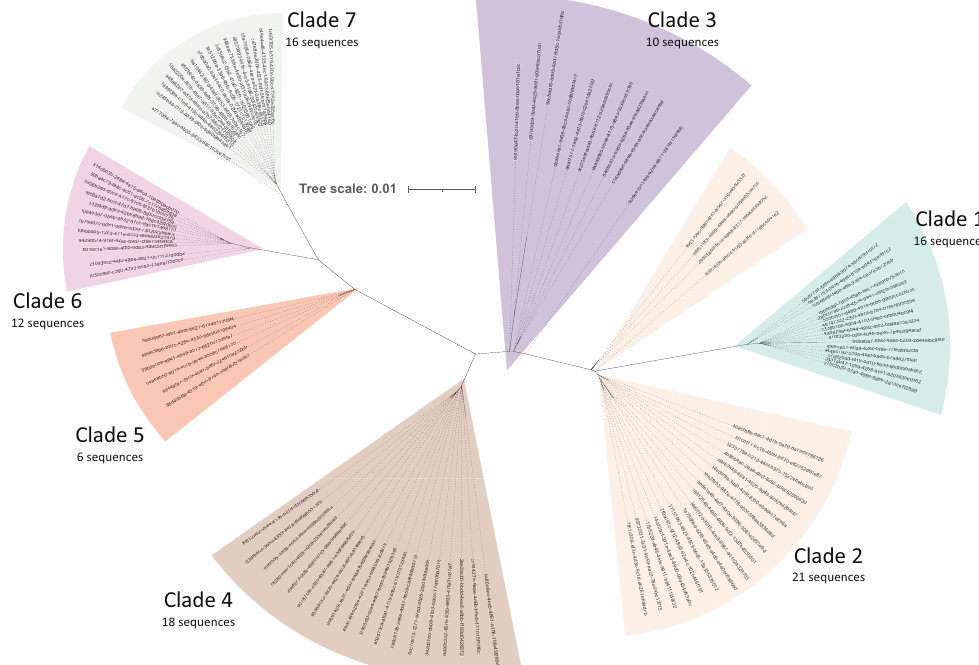
Fig. 5 Duganella phylogenetic tree based on clustering at 90% identity. The 99 Duganella RoC-ITS sequences form 7 distinct clades consistent with the number of rrns in other related Duganella strains with complete genomes. Note that because many of the differences were associated with gapped regions, for this tree all dashes in the MSA were replaced with A ’ s thereby better capturing the relationship between the distinct rrns. The tree scale shows the number of edits per base per unit